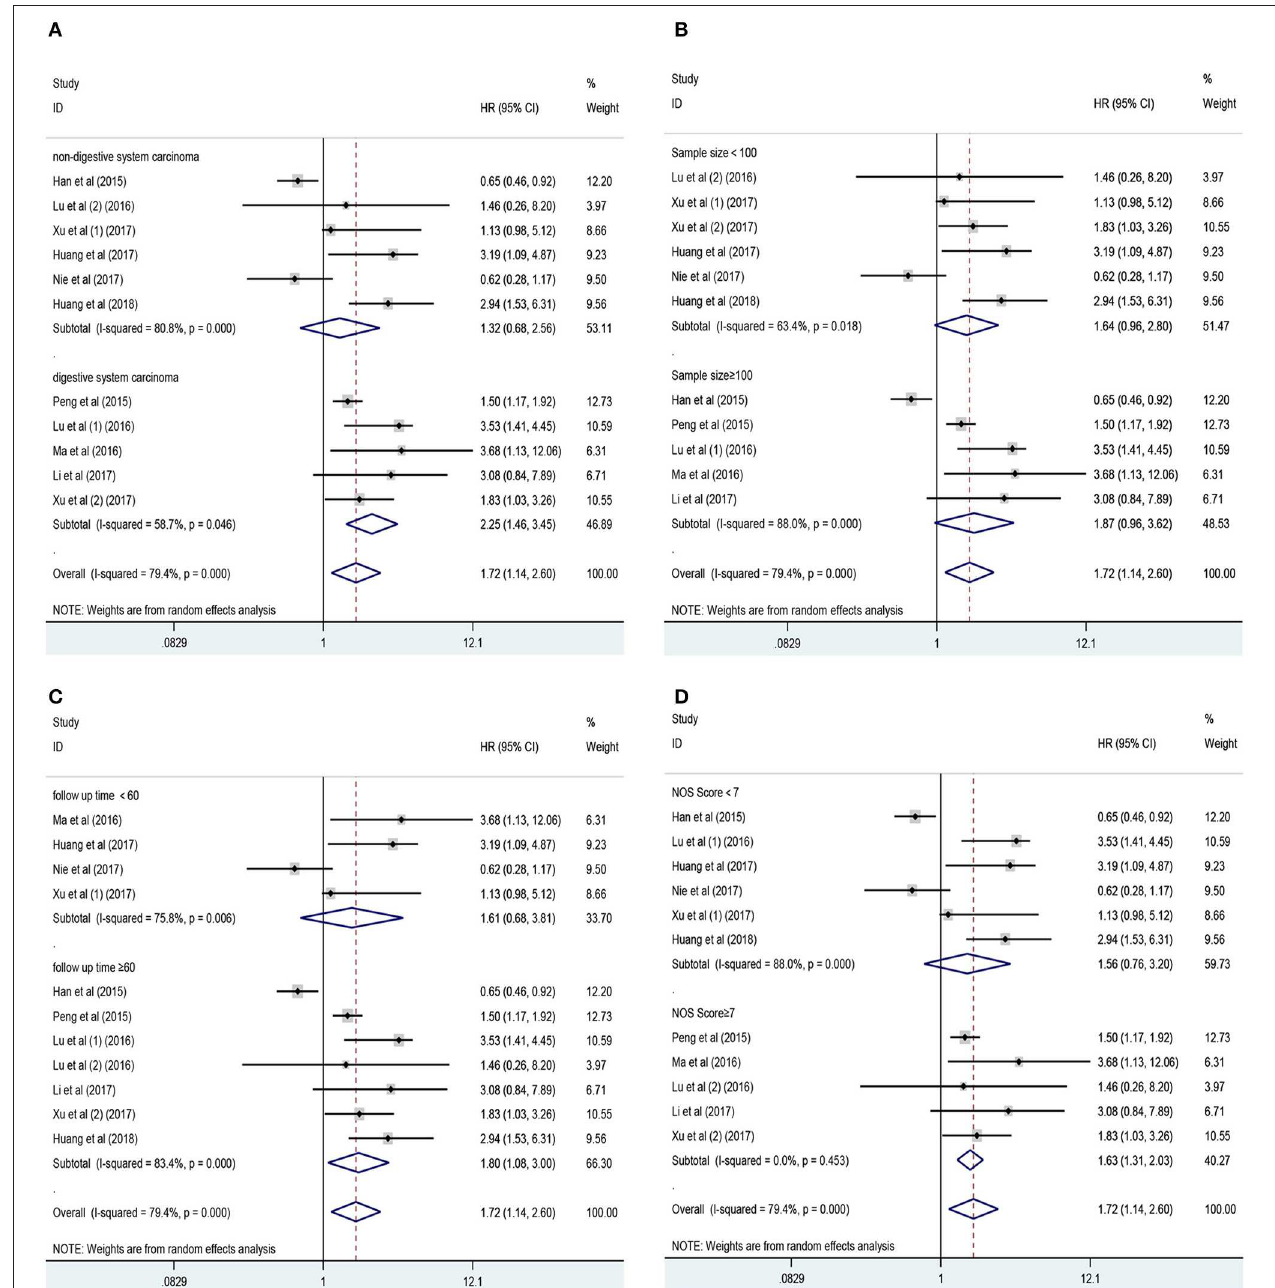
FIGURE 3 | Results of subgroup analysis of pooled HR of OS for malignancy patients. (A) Subgroup analysis stratified by type of cancer. (B) Subgroup analysis stratified by sample size. (C) Subgroup analysis stratified by follow-up time. (D) Subgroup analysis stratified by NOS